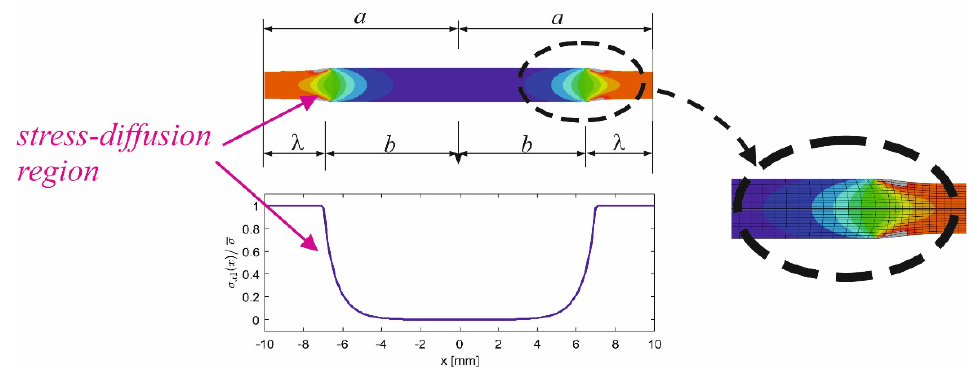
Fig. 2 Qualitative comparison between the numerically evaluated axial stress (with evidence of the stress diffusion inside the bonded zone) and the analytically evaluated mean axial